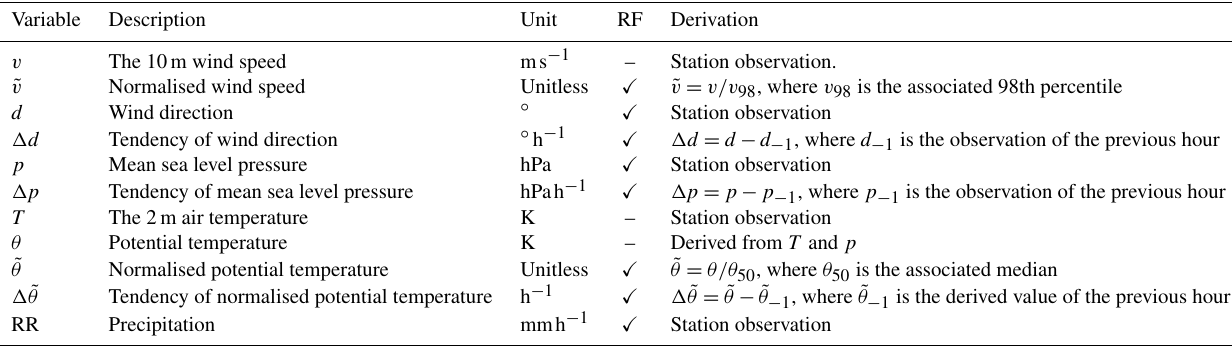
Table 1. Overview of the variables considered for the objective identification using the probabilistic RF. The fourth column indicates whether the variable is used as an input variable for the final version of the RF. The associated percentiles and medians are computed with respect to the location, time of day and day of the year ± 10d.